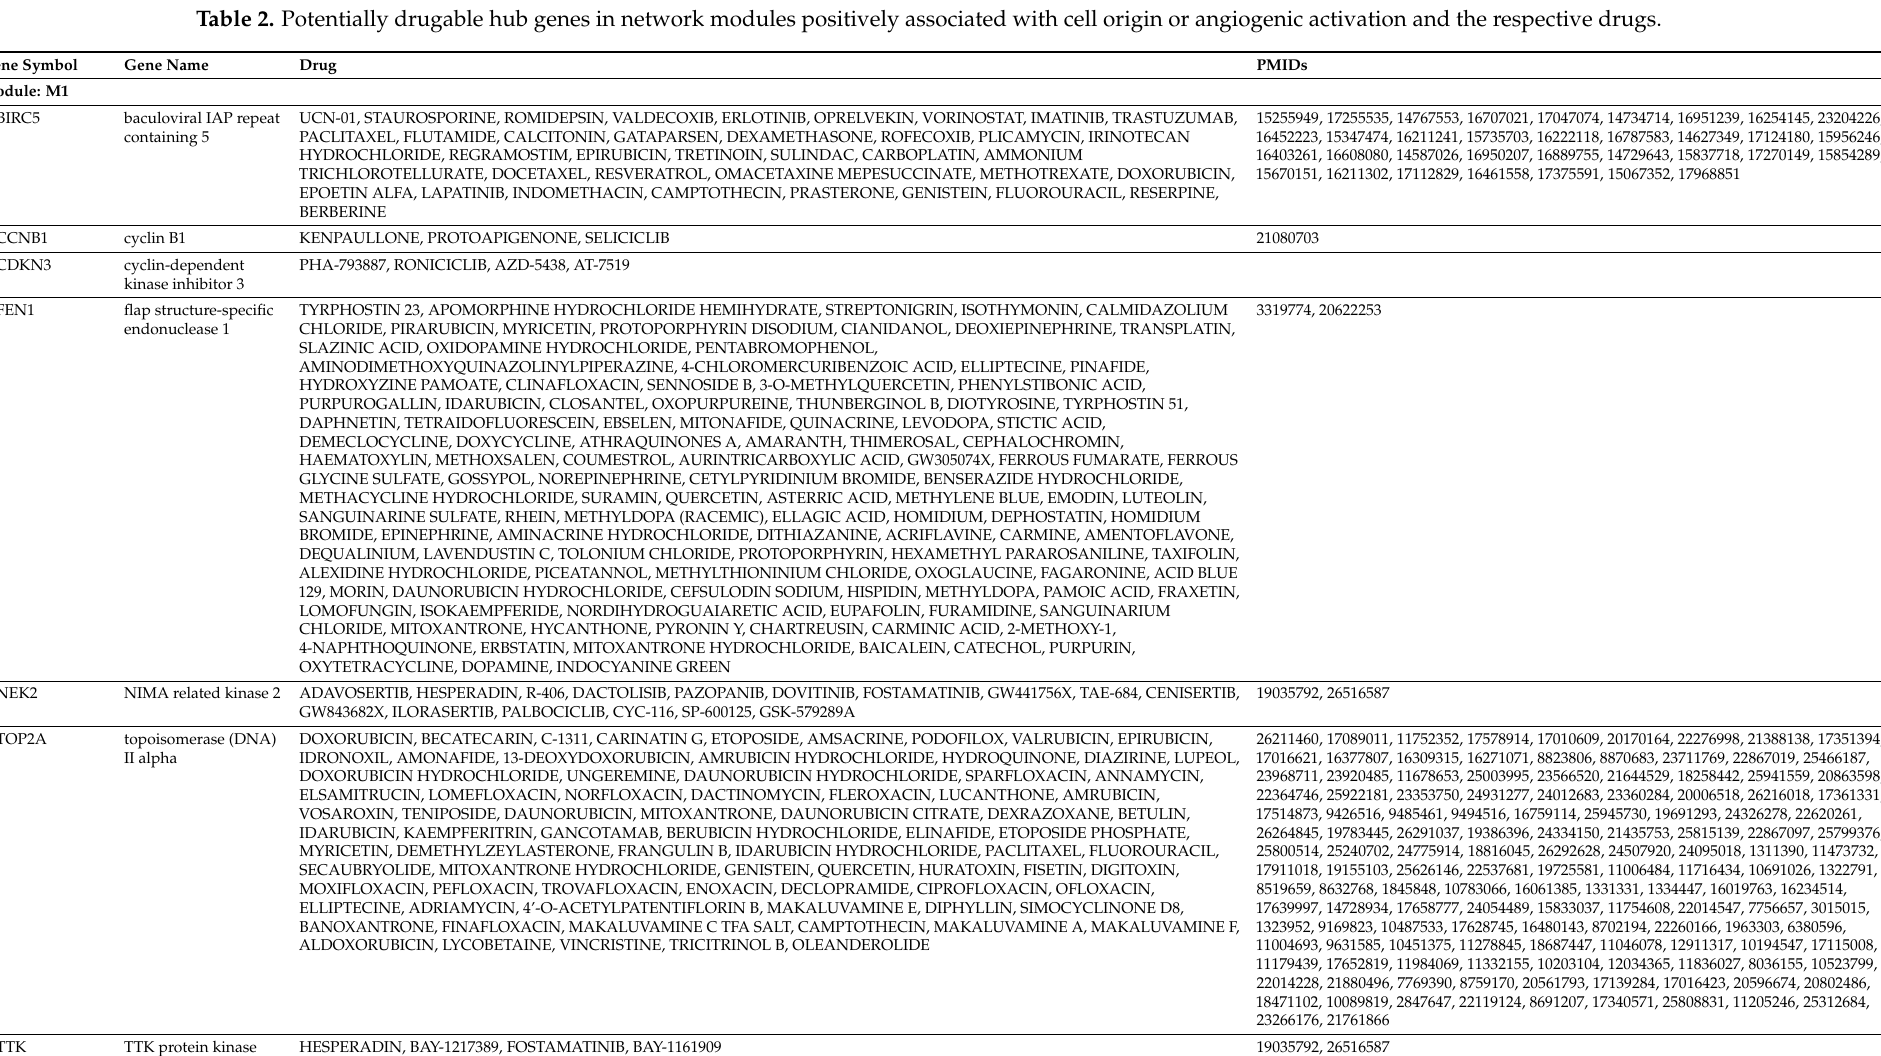
Table 2. Potentially drugable hub genes in network modules positively associated with cell origin or angiogenic activation and the respective